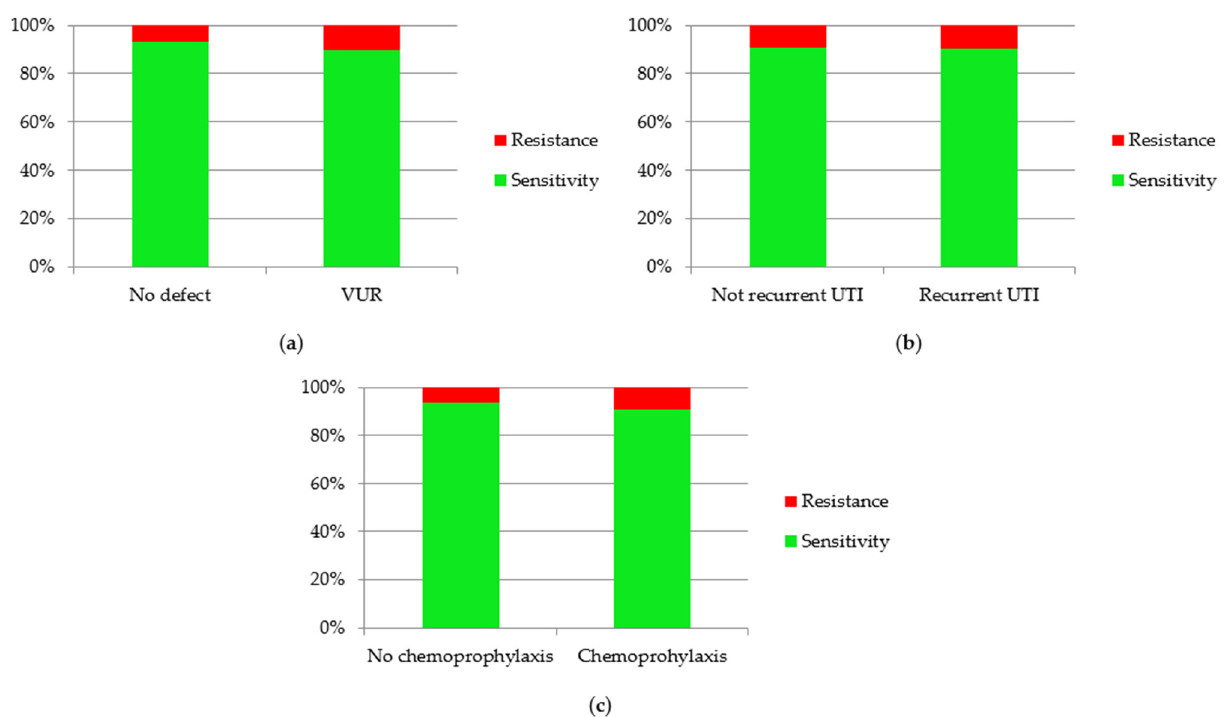
Figure 9. Sensitivity and resistance of Escherichia coli to antibiotics in children with: ( a ) VUR; ( b ) recurrent UTI; ( c ) chemoprophylaxis.